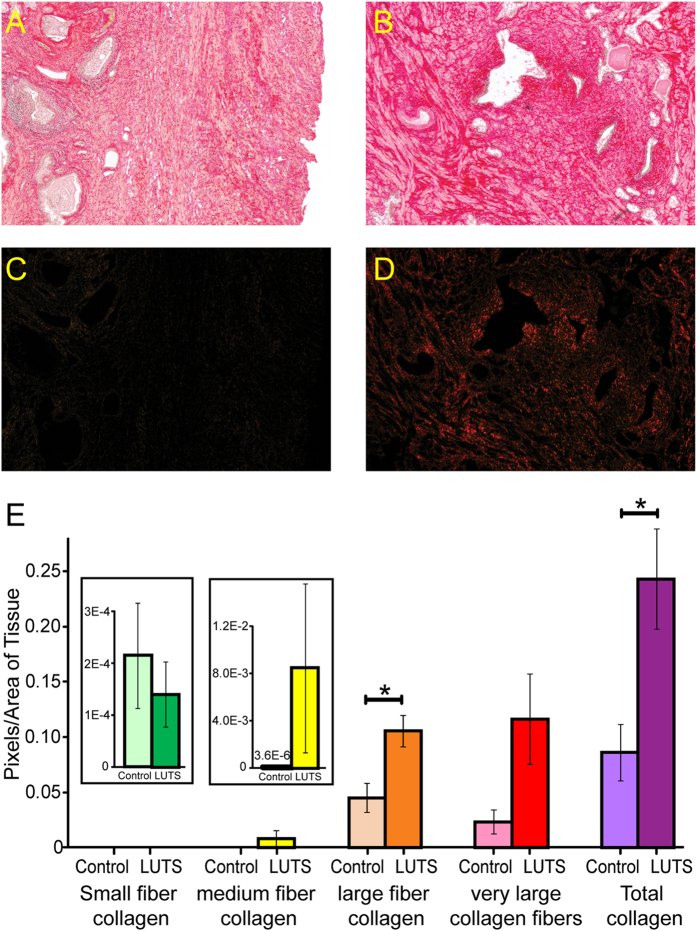
Determination of prostatic collagen content in patients.Picrosirius red stained images of tissues were captured under brightfield illumination (A, Control; B, LUTS) and under polarized light (C, Control; D, LUTS). Collagen content was colormetrically quantified for fibers with different sizes and the total collagen (E). (Note, *p-value < 0.05).